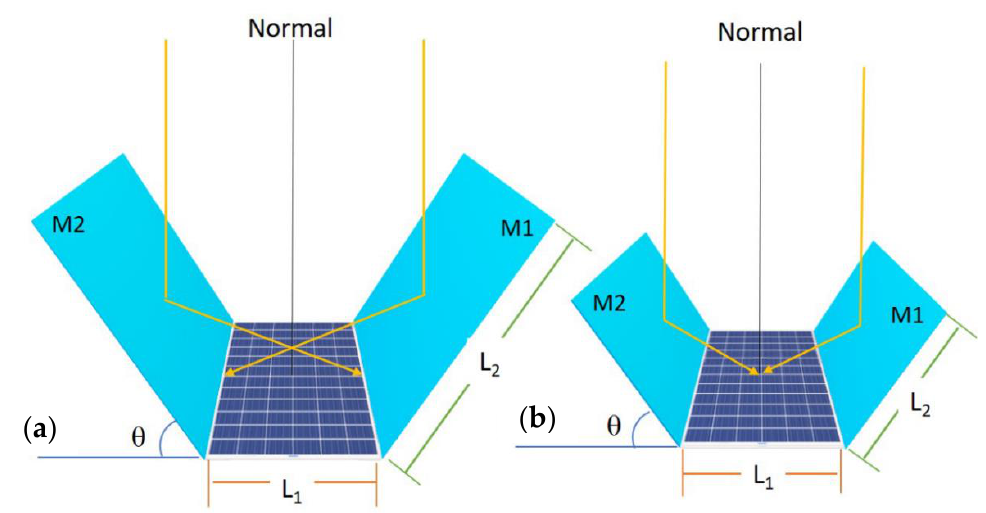
Figure 2. The two cases of mirrors’ length: ( a ) double coverage (L 2 = 2 L 1 ) and ( b ) partial coverage (L 2 = L 1 ). Here, L 1 is the width of the PV panel; L 2 is the width of both mirrors (M1 and M2), and θ the inclination angle for each mirror.